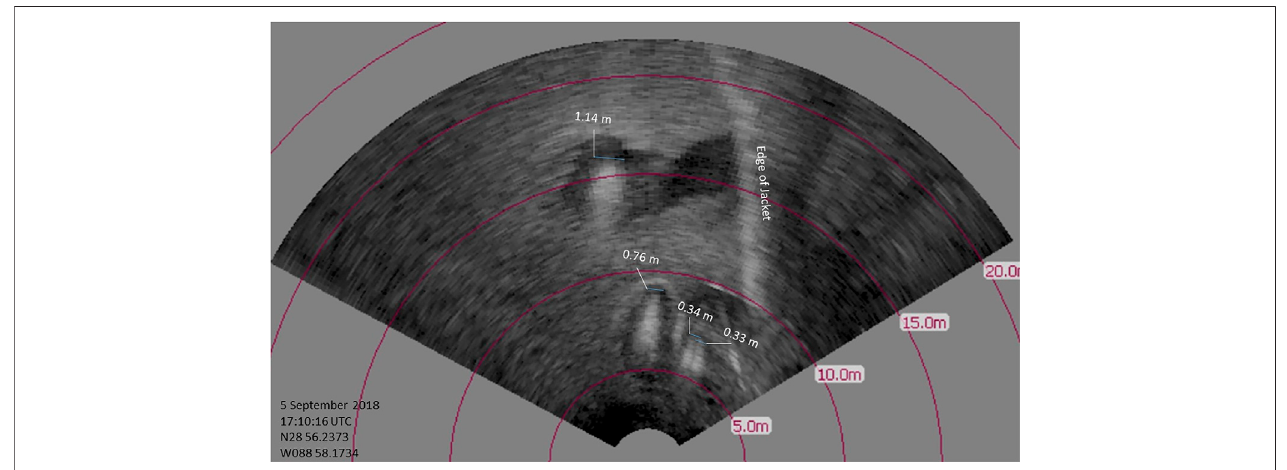
FIGURE 7 | Imaging sonar perspective of erosion crater and plume sources from the ROV: MC20 jacket in the background and multiple plumes observed in the foreground, original Fig. 3.21 (Mason et al., 2019).